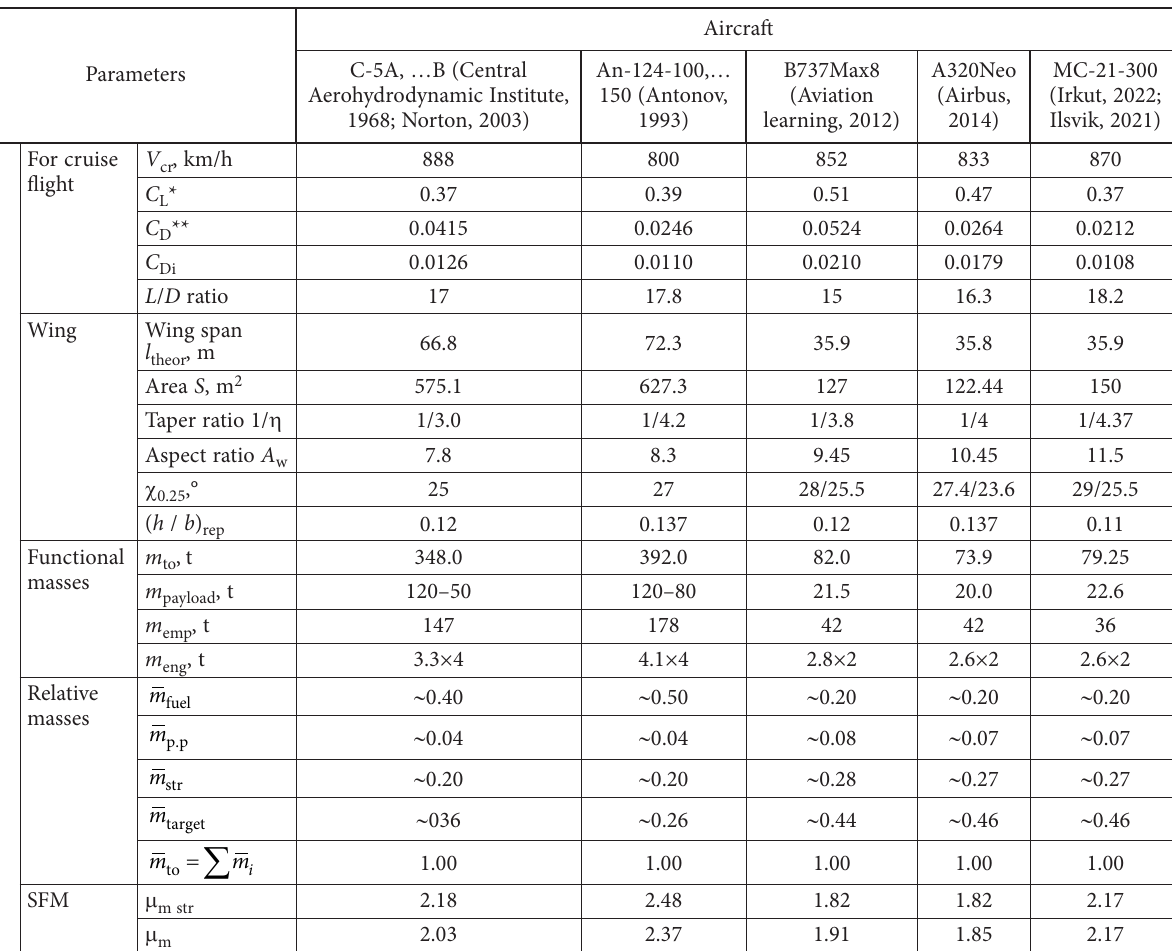
Table 2. Main parameters of five transport category aircrafts